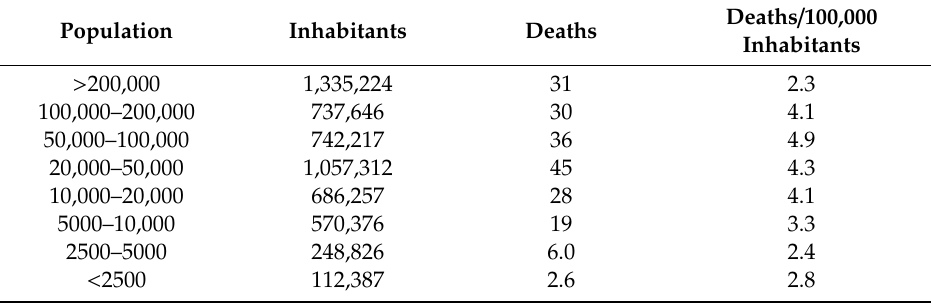
Table 4. Deaths attributable to RWC, classified by population size in a